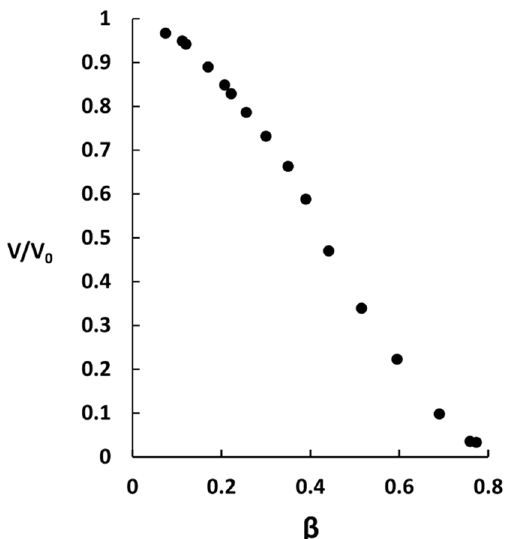
Figure 2. Swelling isotherms for polyacrylate microgels in a limited volume of AMT solution of 10 mM ionic strength. Microgel volume ratio is plotted vs. binding ratio and each point represents a separate experiment.